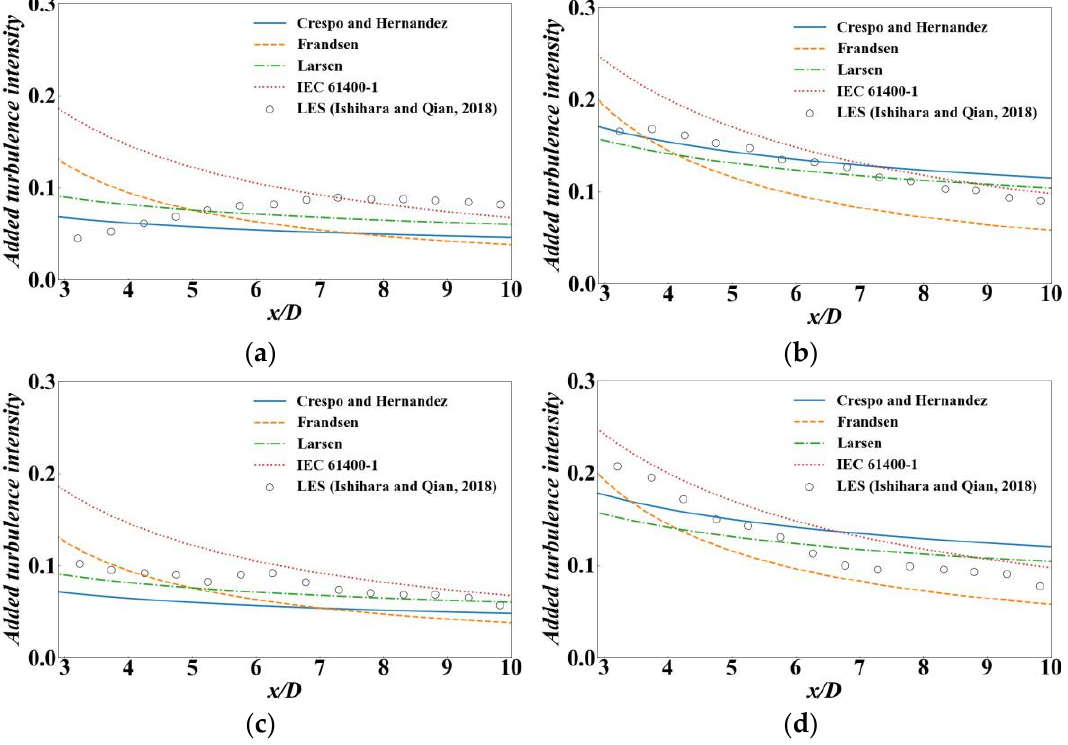
Figure 3. Comparison of the streamwise distributions of added turbulence intensity between nu- merical simulations [5] and empirical models: ( a ) I 0 = 0.035, C T = 0.36; ( b ) I 0 = 0.035, C T = 0.84; ( c ) I 0 = 0.137, C T = 0.36; ( d ) I 0 = 0.137, C T = 0.84 .